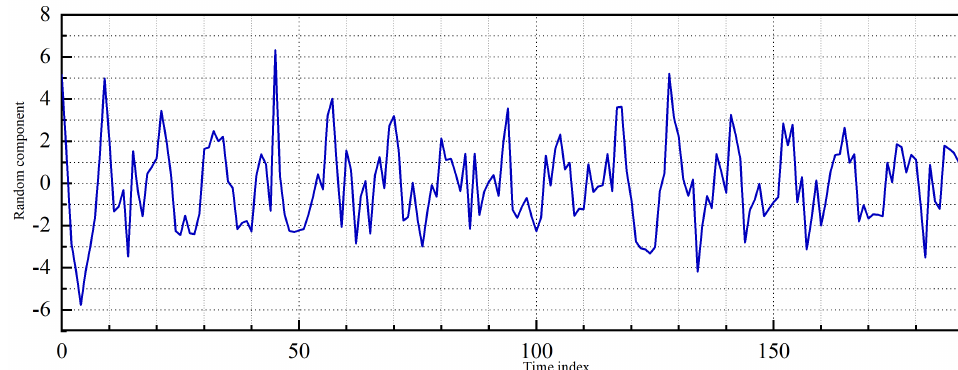
Figure 9. Random component.